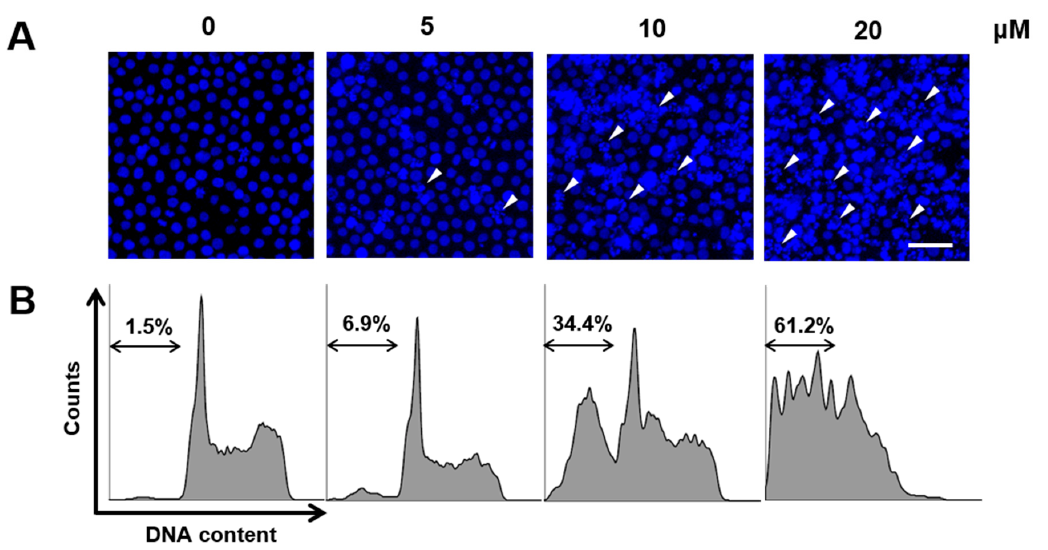
Figure 3. Apoptosis of HL-60 cells mediated by CT. ( A ) Confocal microscopic images showing nuclear staining using Hoechst 33342 and ( B ) flow cytometry using propidium iodide (PI) for